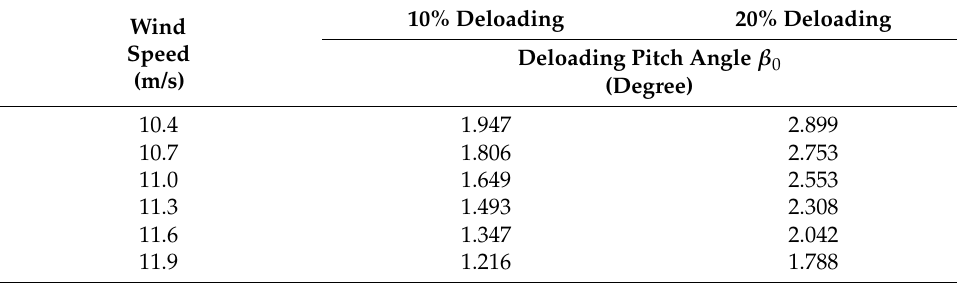
Figure 4. Algorithm of the CDS.